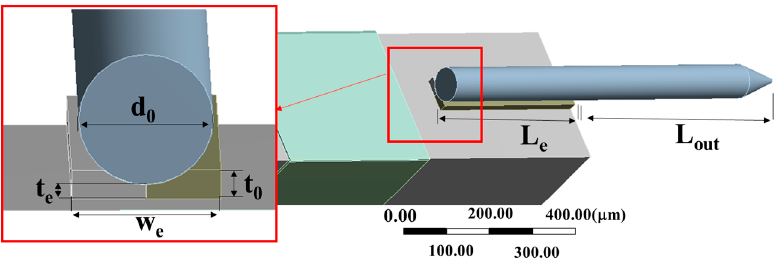
Figure 6. Model of the probe connection.